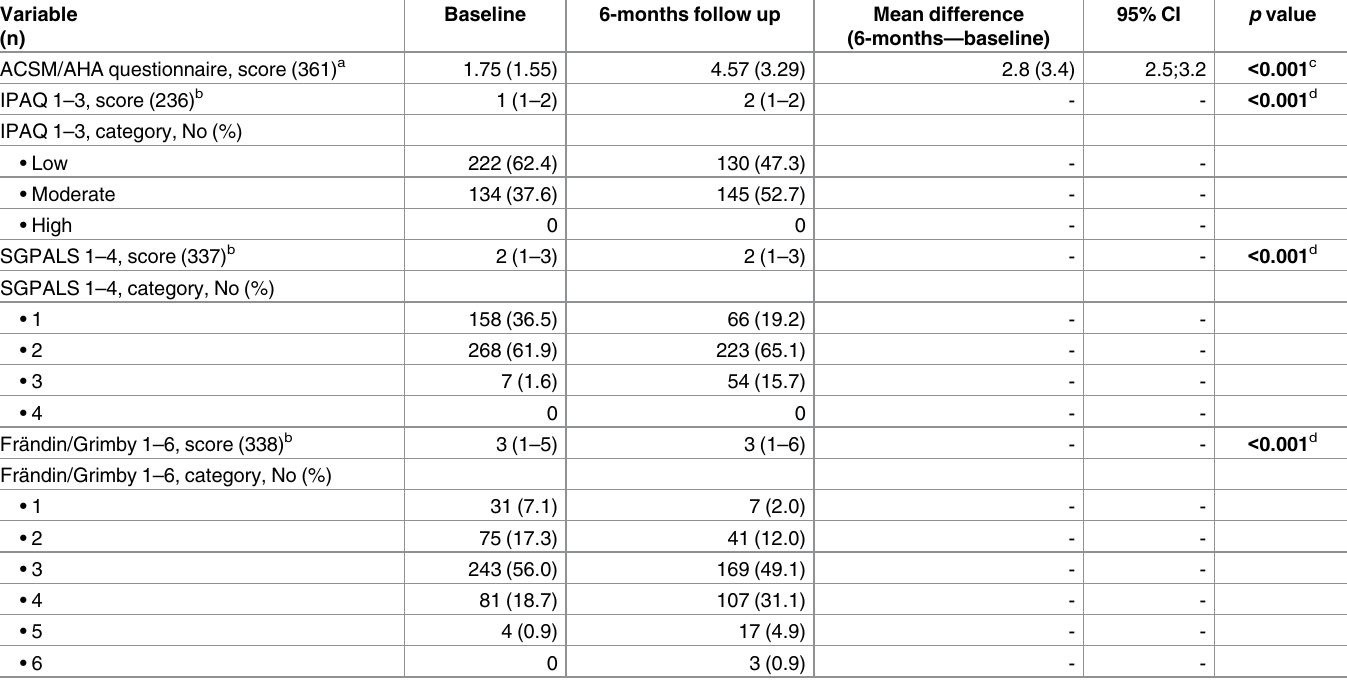
Table 4. Descriptivestatistics and differences for physical activity level at baseline and 6-months follow-up.